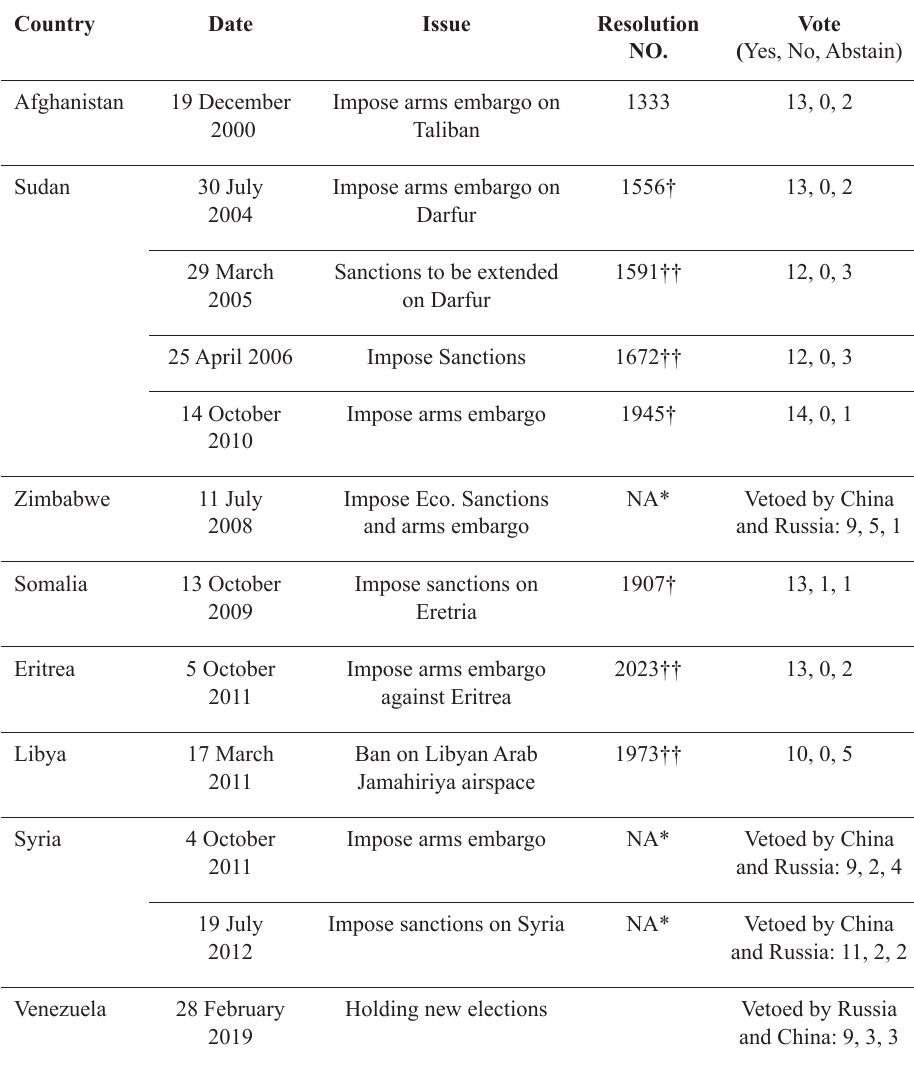
Table 1. China’s negative votes on sanctions